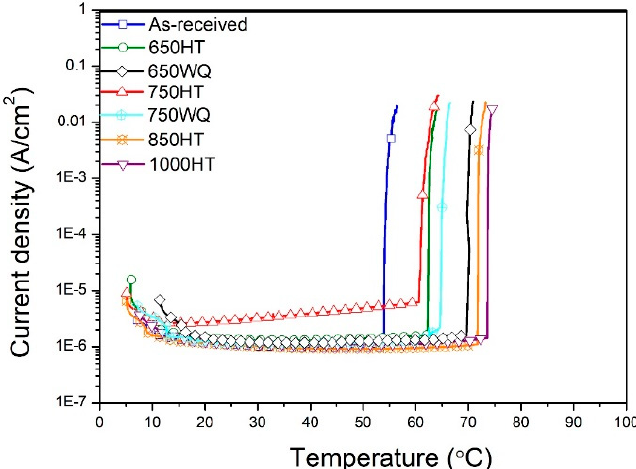
such as Ti 3 Al in the 750HT and 650HT samples may play advantageous roles on the repassivation of the matrix (compared with the 750WQ and 650WQ samples).